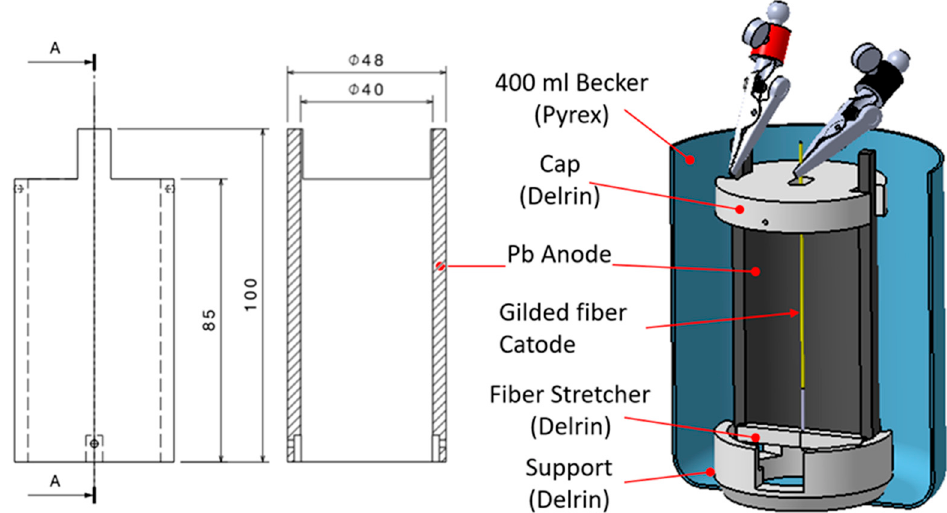
Figure 2. ( a ) Layout and ( b ) experimental picture of the spu tt er vacuum chamber operation.